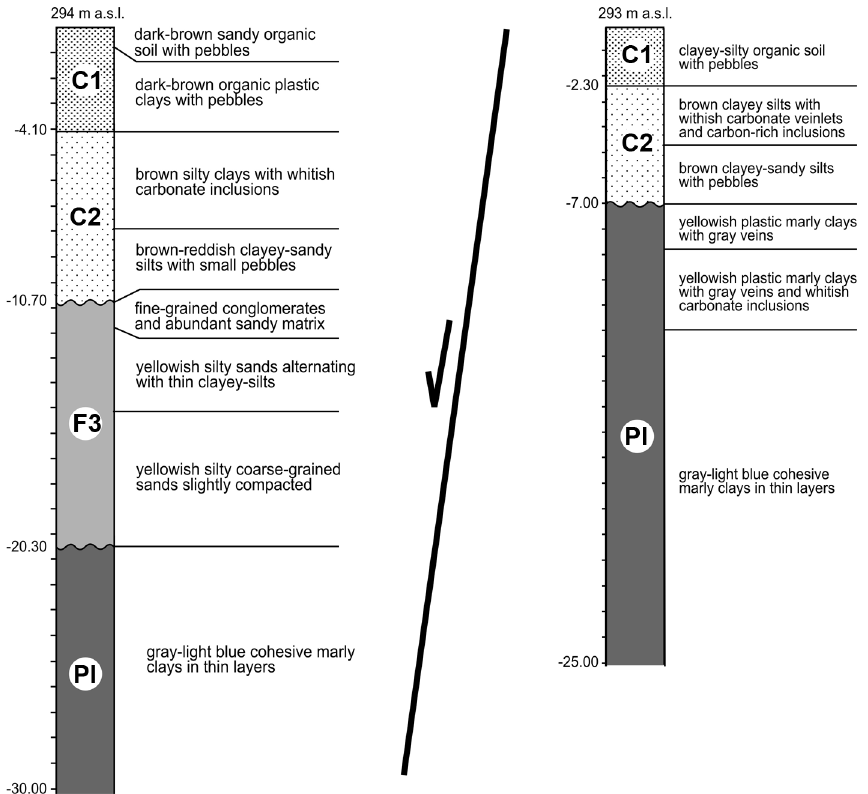
Fig. 5. The two stratigraphic boreholes used to calibrate the electrical resistivity tomographies. For location see fig. 3a,b. F n – alluvial body associated with terrace T n ; C n – alluvial cone associated with the fluvial body F n ; Pl – Pliocene marls-clays of the Caliandro